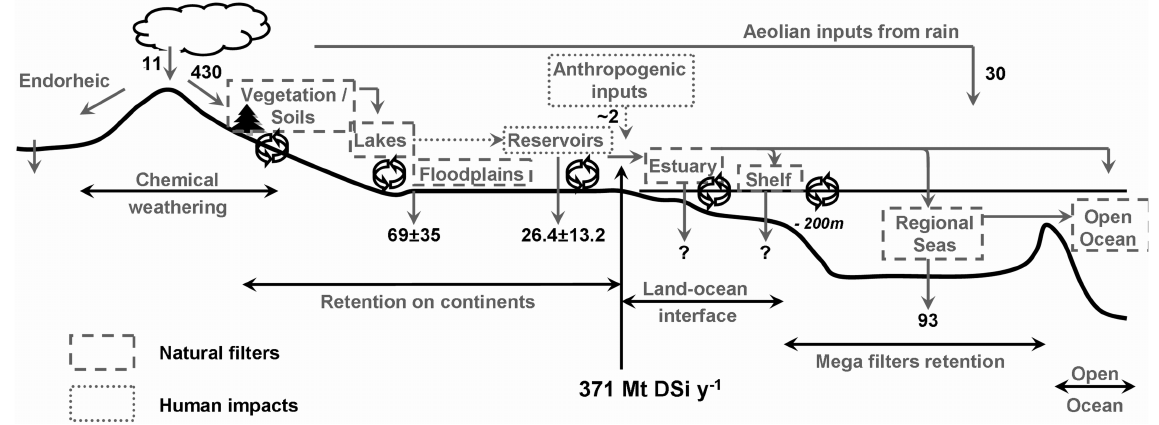
Fig. 6. Conceptual pathways of dissolved silica from land to oceans with cascading filters on land and nested filters at the land-ocean interface. Dotted: anthropogenic components. All numbers are in Mt DSi per